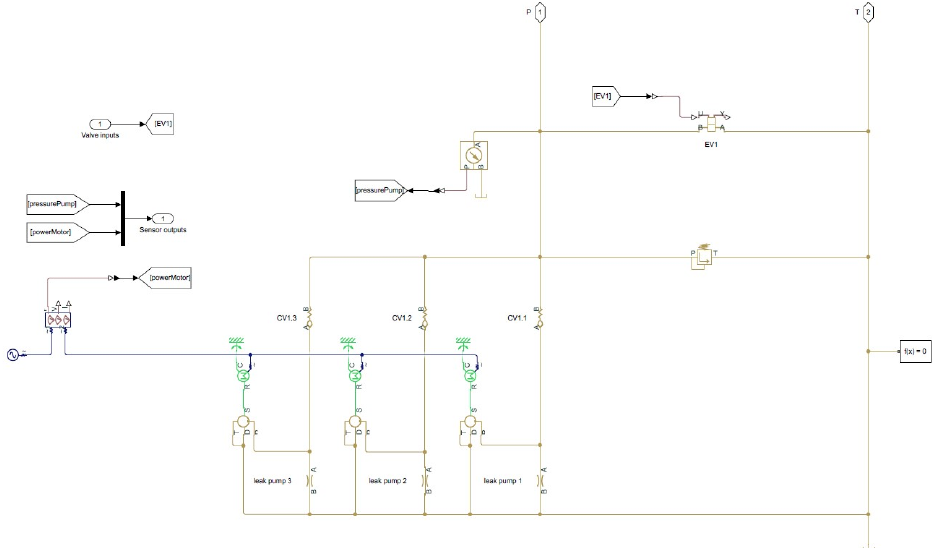
Figure 4. Power unit